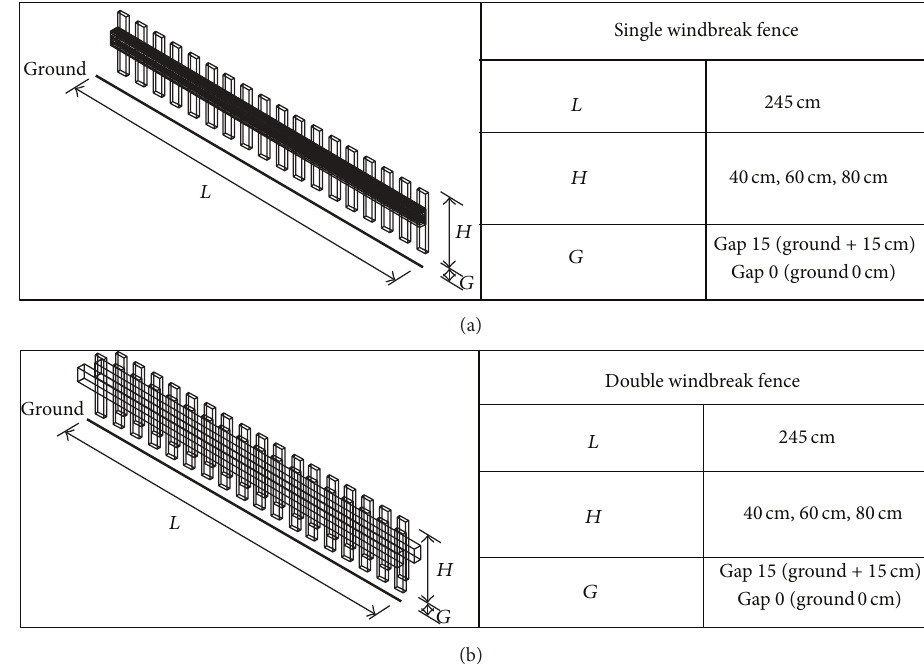
Figure 4: Dimension of the CFD Model for linear windbreak fences.